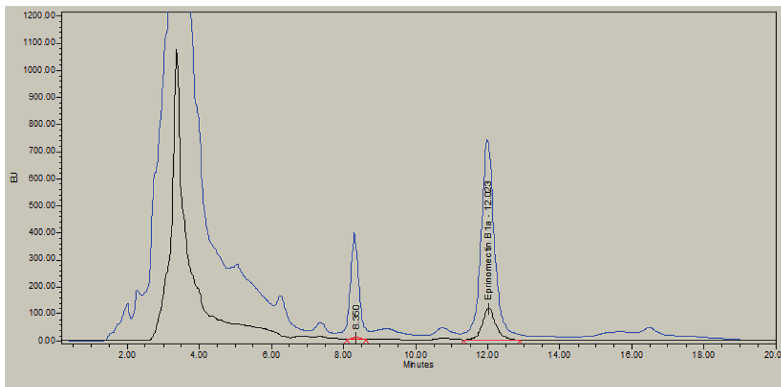
Figure 4: Comparison between fortified liver samples to 10 μg kg -1 and 100 μg kg -1 eprinomectin B